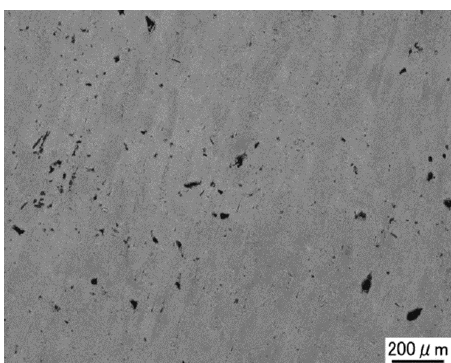
Figure 13. OM image of a vertical cross section of the SLM composite fabricated with the Cu plated